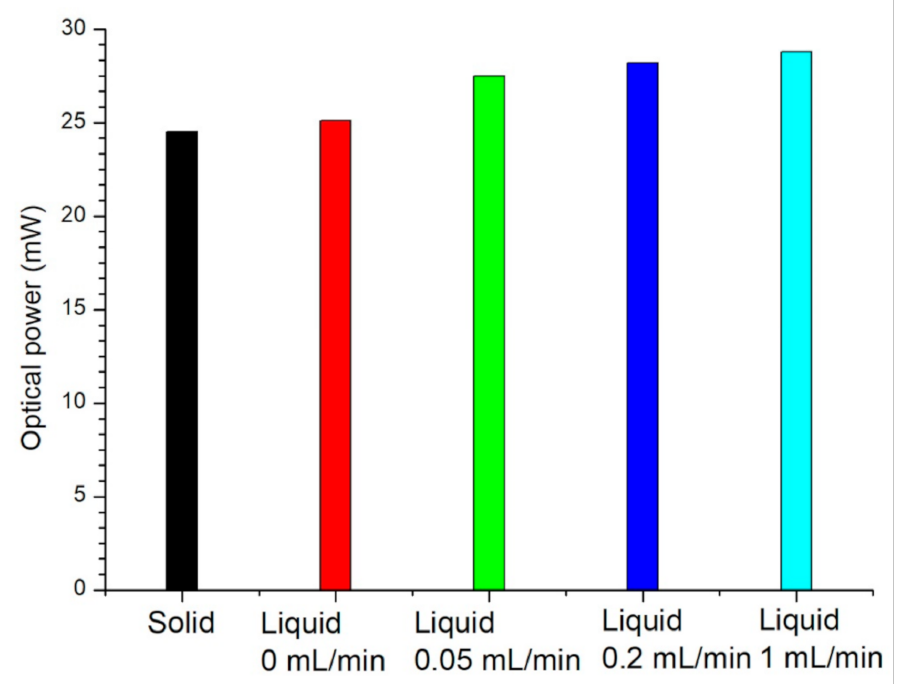
Figure 12. Optical power of the LED at 480 min using solid conductor and graphene solution with various flow